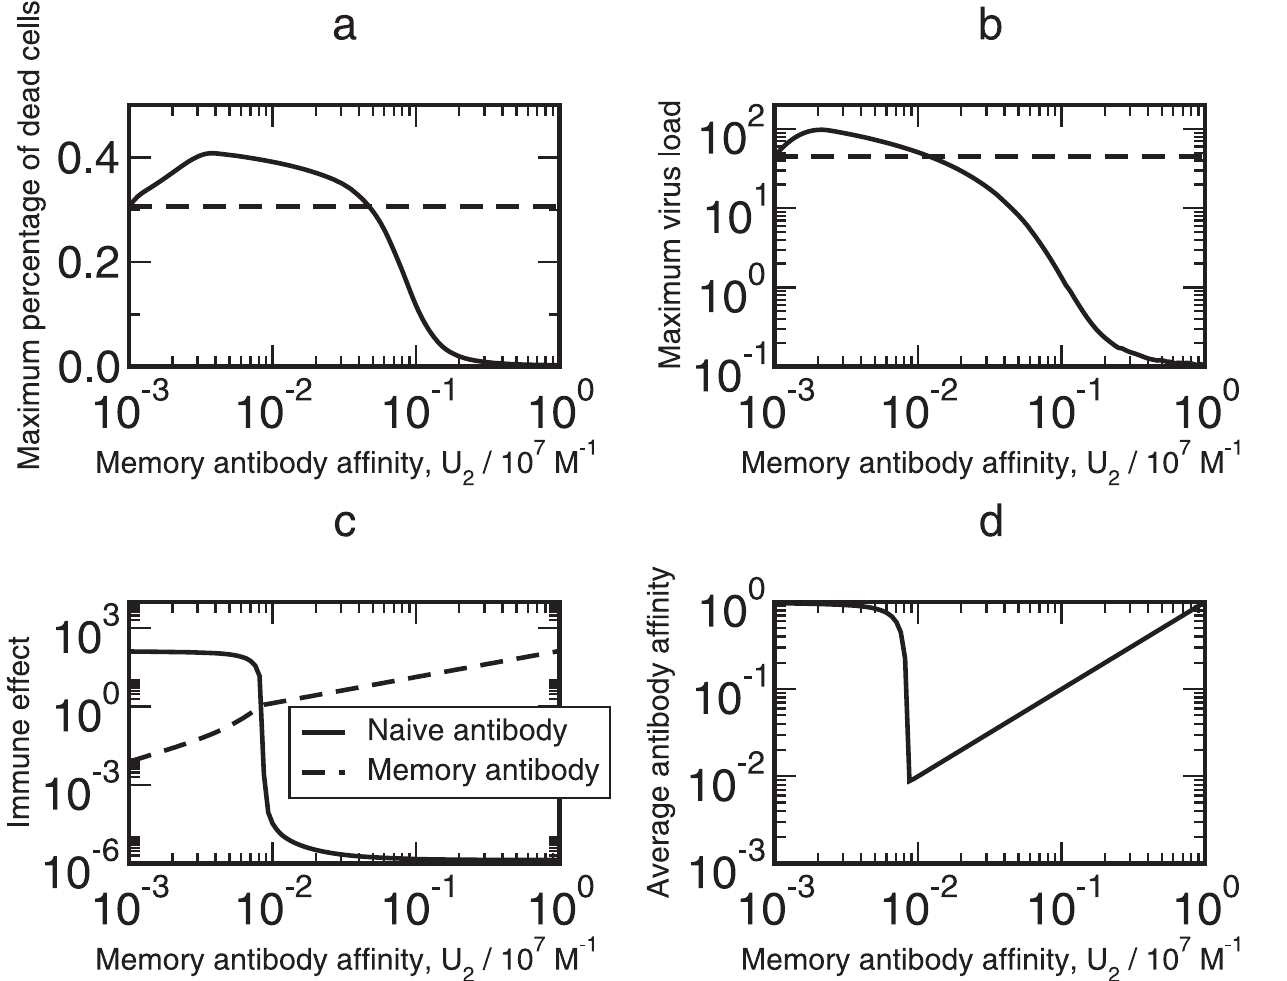
Figure 3. Trajectories of the maximum percentage of dead cells, the maximum viral load, the cumulative effects of naı¨ve and memory antibodies defined by equations 9 and 10, respectively, and the final average antibody affinity defined by equation 11 with different memory antibody affinities U 2 . The dashed horizontal lines in (a) and (b) are the maximum percentage of dead cells and the maximum viral load, respectively, at the lowest memory antibody affinity U 2 ~ 10 { 3 .